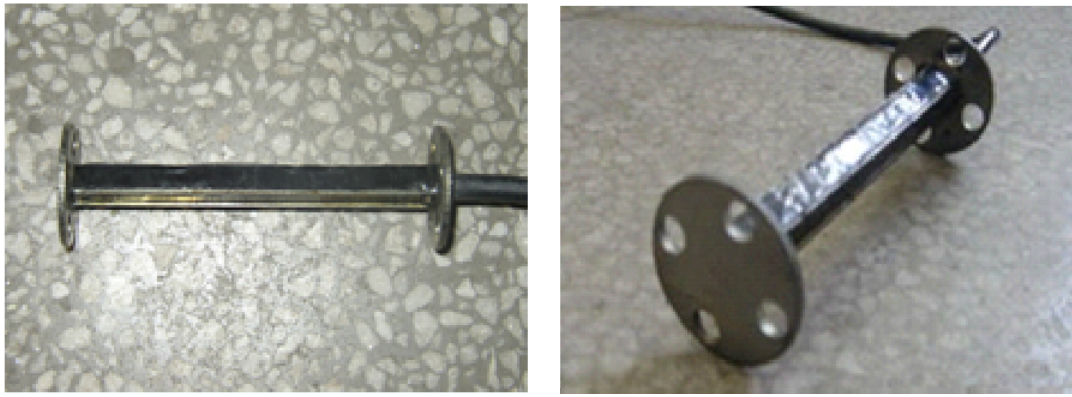
Figure 5. Photos of the embedded strain gauge